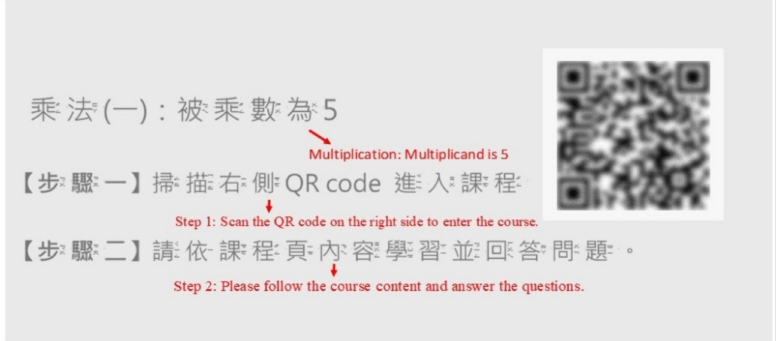
Figure 1. QR Code printed on a worksheet for students to scan and read the digital content.